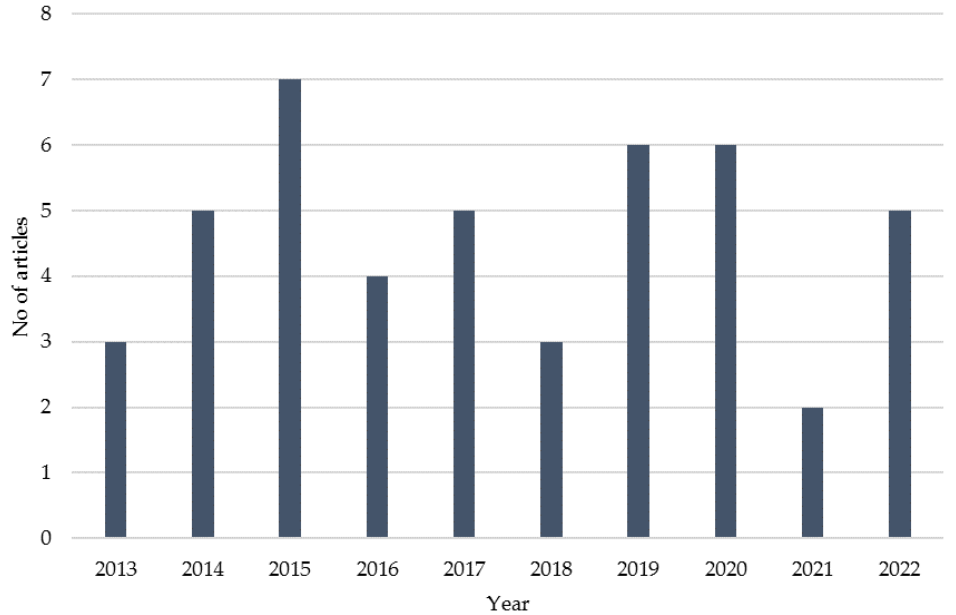
Figure 4. Number of publications per year.